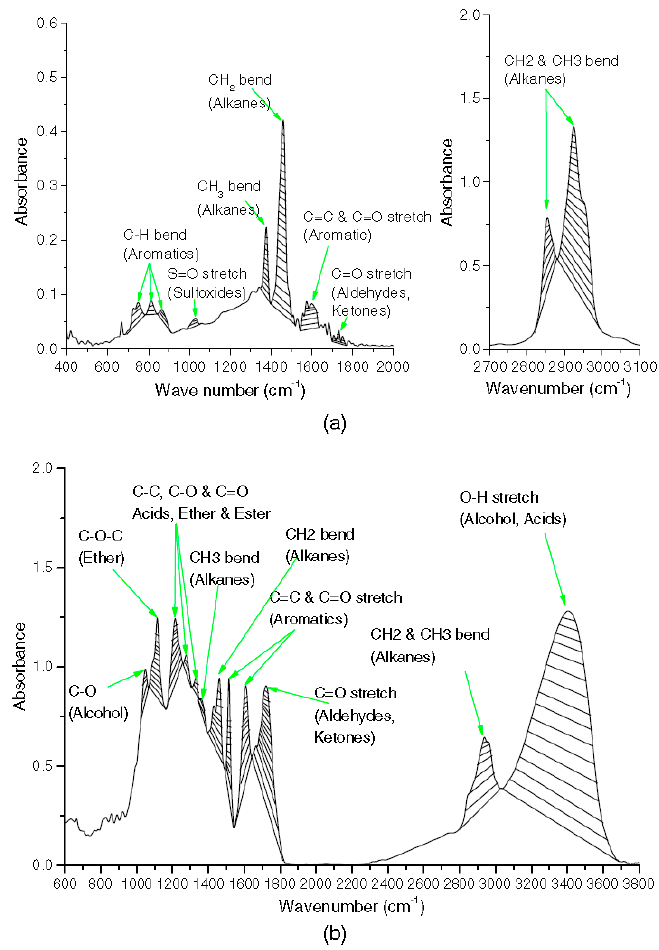
Figure 3. Spectra and functional groups: ( a ) Spectra and functional groups for the asphalt binder; ( b ) spectra and functional groups for the biobinder [27]. Table 3. Functional groups and corresponding wavenumber in infrared spectra [28].